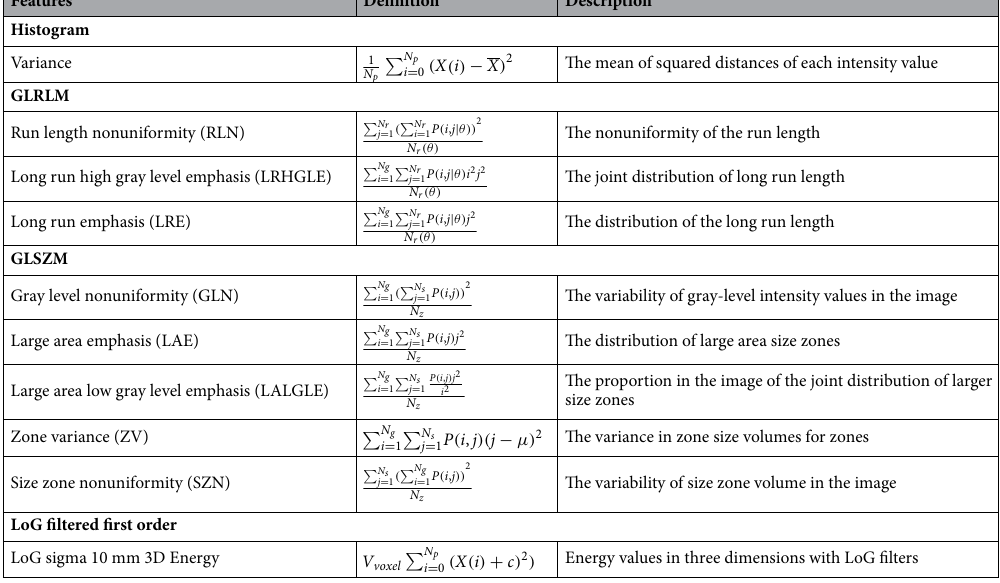
Table 1. Definition of the 10 ML features.